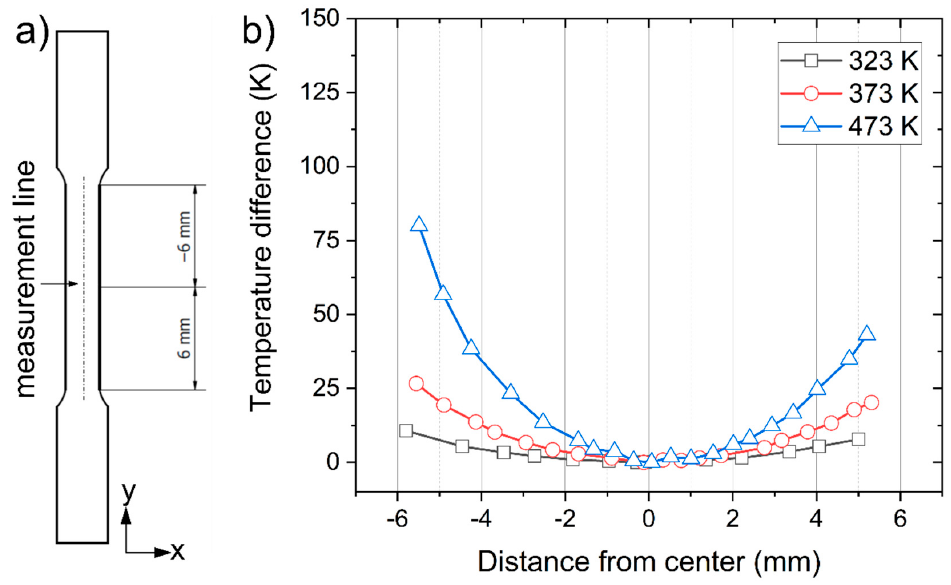
Figure 5. ( a ) Measurement line of thermal distribution, and ( b ) thermal distribution along the measurement line. The heat generation caused by Joule heating can be approximated using the formula from [13]: